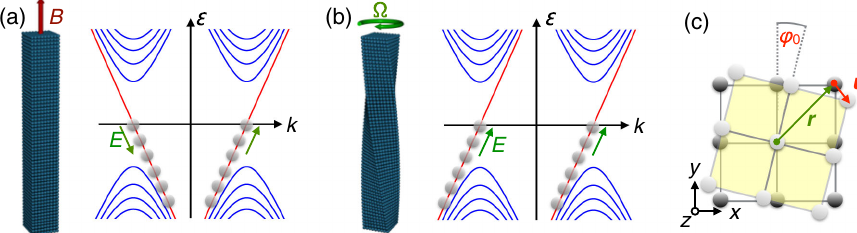
FIG. 1. Electron excitation spectra in a Weyl semimetal in the presence of (a) magnetic field B and (b) pseudomagnetic field b generated by a torsional deformation. Parallel electric field E produces a charge-density imbalance in case (a), while it appears to produce excess total charge density in case (b). Panel (c) illustrates the displacement field u in the presence of torsion. Consecutive layers of the crystal are rotated by relative angle φ 0 ¼ Ω ð L=a Þ